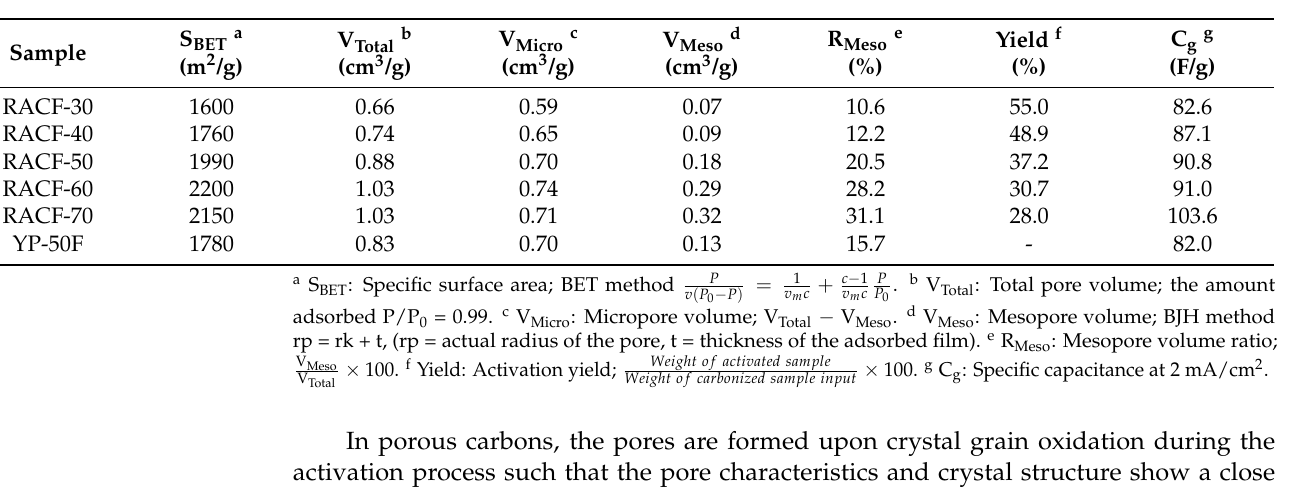
Table 1. Textural properties of RACF as a function of various activation